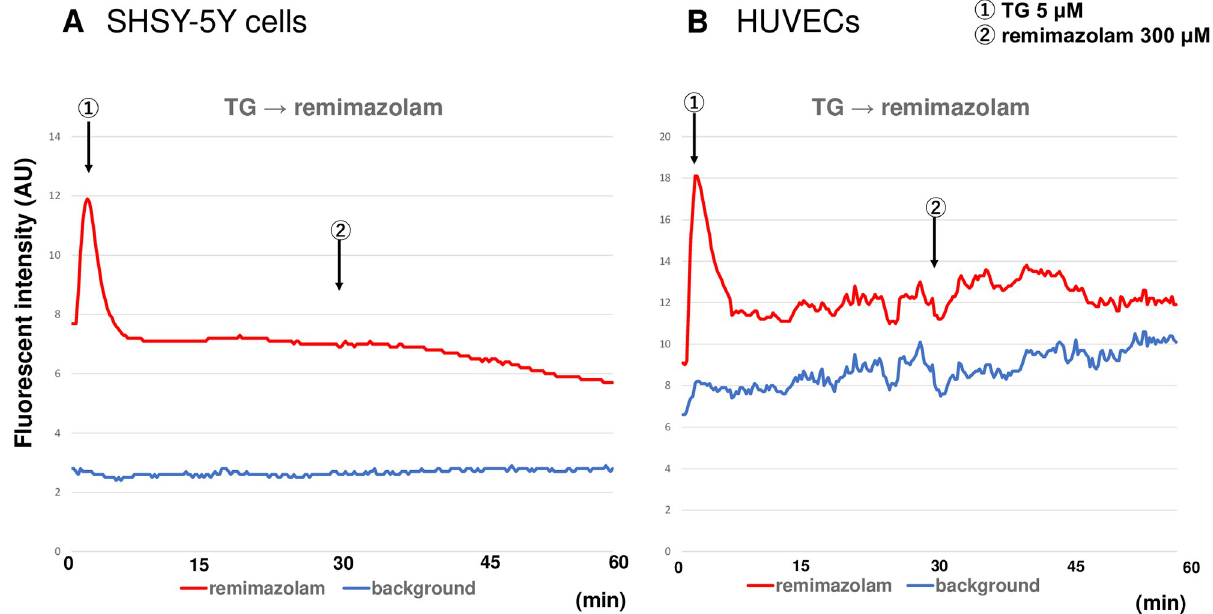
Fig 5. Effects of thapsigargin on remimazolam-induced calcium elevation. (A) Following the administration of 5 μ M thapsigargin (TG), a Ca 2 + -ATPase inhibitor ( ① ), the [Ca 2+ ] i was elevated in SHSY-5Y cells. Subsequently, remimazolam at 300 μ M was administered 30 min after the TG administration ( ② ). Remimazolam did not induce any calcium elevation, suggesting that remimazolam mobilized calcium from ER. (B) Following the administration of 5 μ M thapsigargin (TG), a Ca 2+ -ATPase inhibitor ( ① ), the [Ca 2+ ] i was elevated in HUVECs. Subsequently, remimazolam at 300 μ M was administered 30 minutes after the TG administration ( ② ). Remimazolam did not induce any calcium elevation, suggesting that remimazolam mobilized calcium from ER. For both experiments, data from one representative experiment are shown.